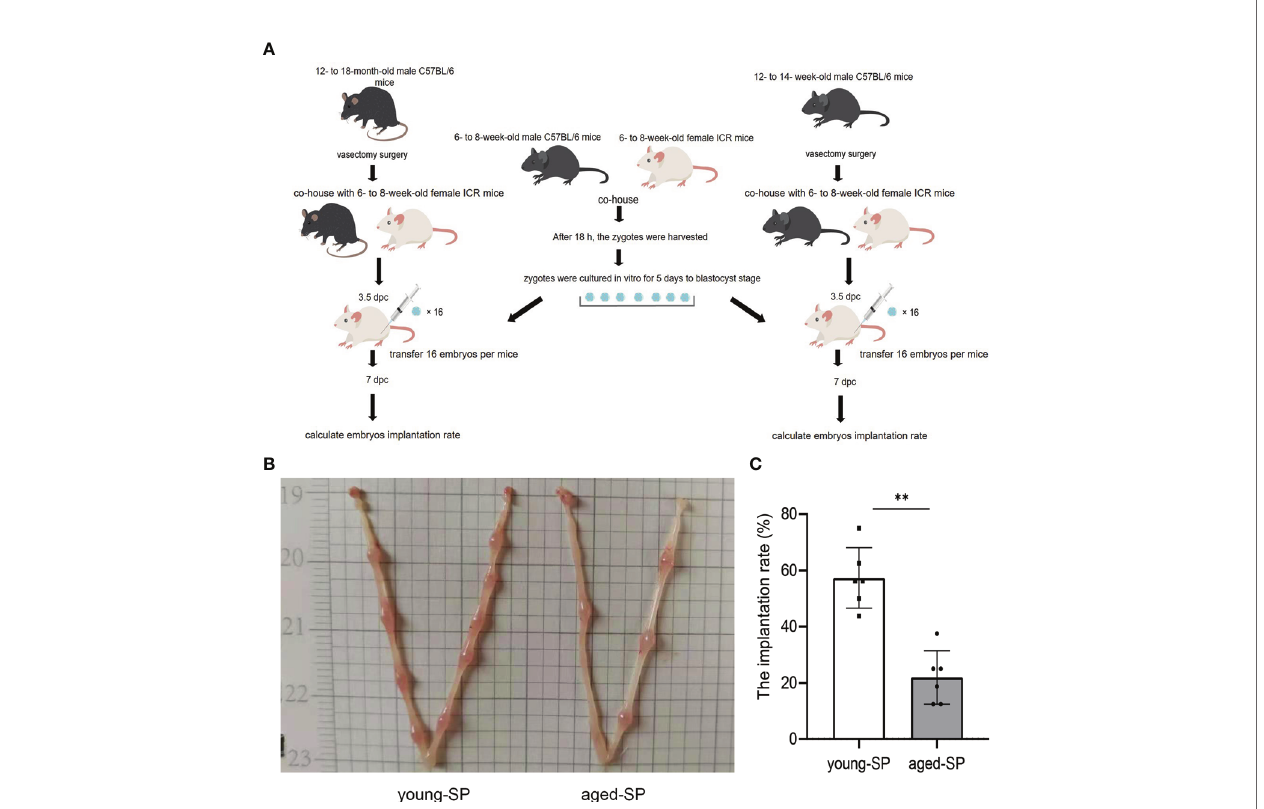
FIGURE 1 | The embryo implantation in the aged-SP group and young-SP group. (A) Schematic diagram of experimental design. (B) Embryo implantation sites of two groups of recipient female mice on 6.5 dpc. (C) Quantitative histogram of embryo implantation rates in two groups of recipient female mice (n = 6). The differences between two groups were assessed by paired-samples t-test. **p < 0.01. The implantation rate (%): the number of implants/number of embryos transferred. SP, seminal plasma; dpc, days post